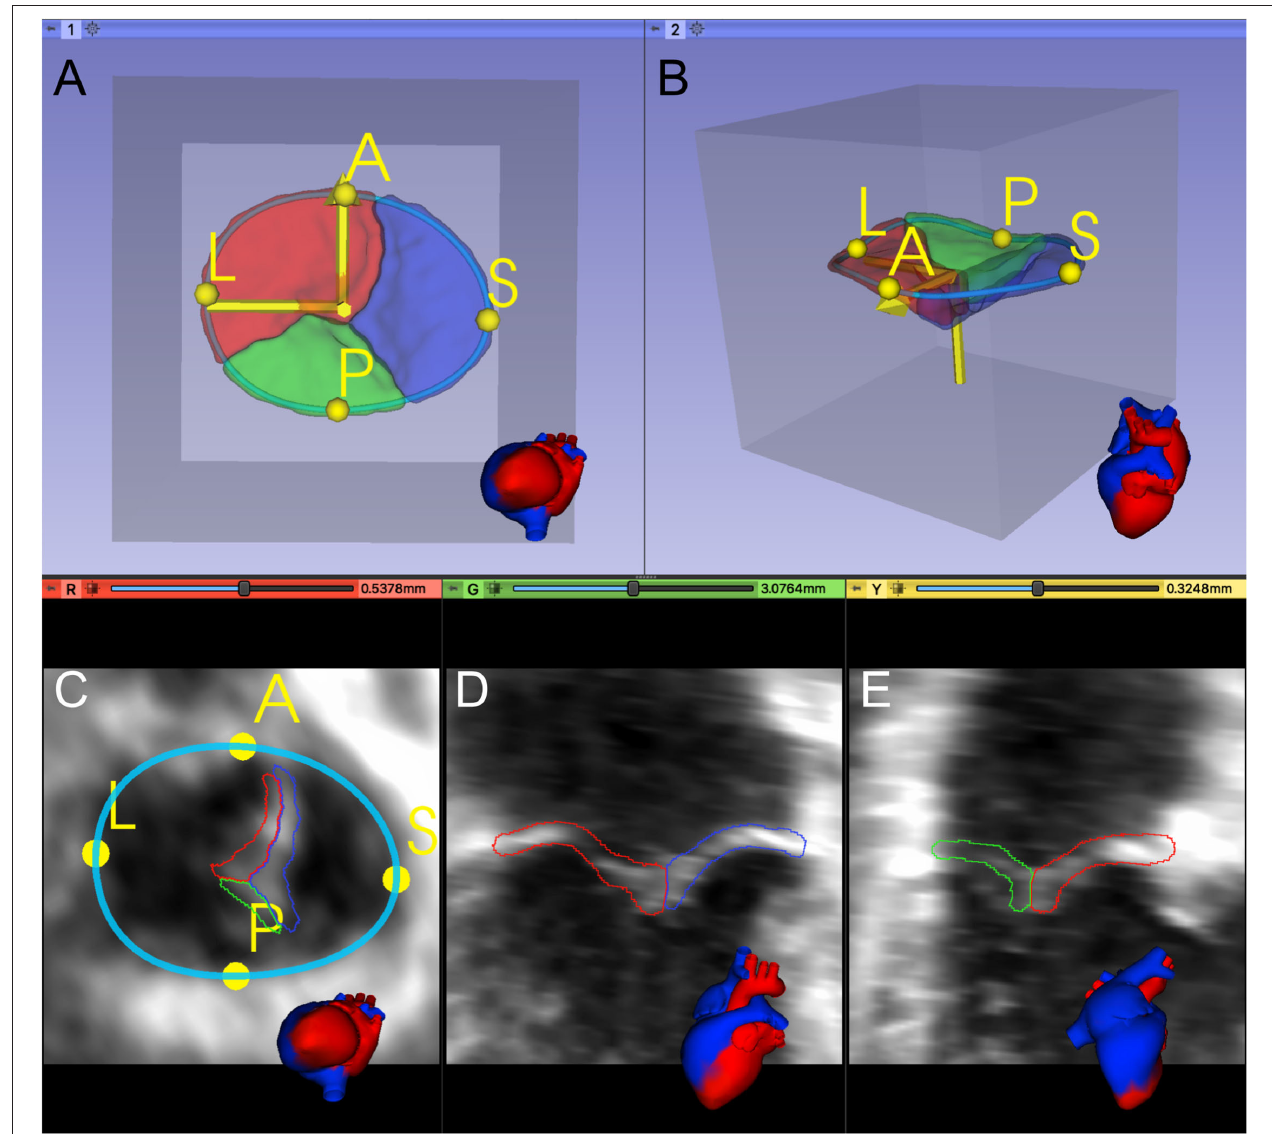
FIGURE 2 | Registration and placement of the segmented TV leaflets inside a predefined Region of Interest (ROI). (A, B) 3D model of the segmented TV in the preprocessed data’s valve coordinate system, created from the A and L landmarks and the APSL centerpoint. (C–E) Orthogonal 2D slices through the preprocessed